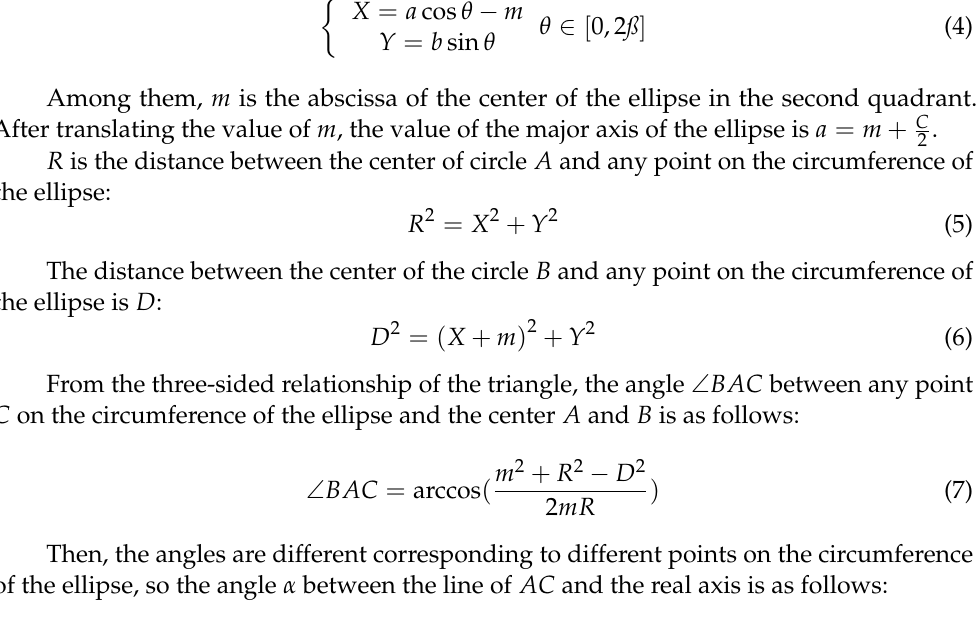
Figure 4. Airfoil with the variable relative thickness position. ( a ) Translation of the major axis of the ellipse along the real axis; ( b ) Translation of the minor axis of the ellipse along the real axis. If the ellipse is translated the distance of m along the real axis ( m is a positive